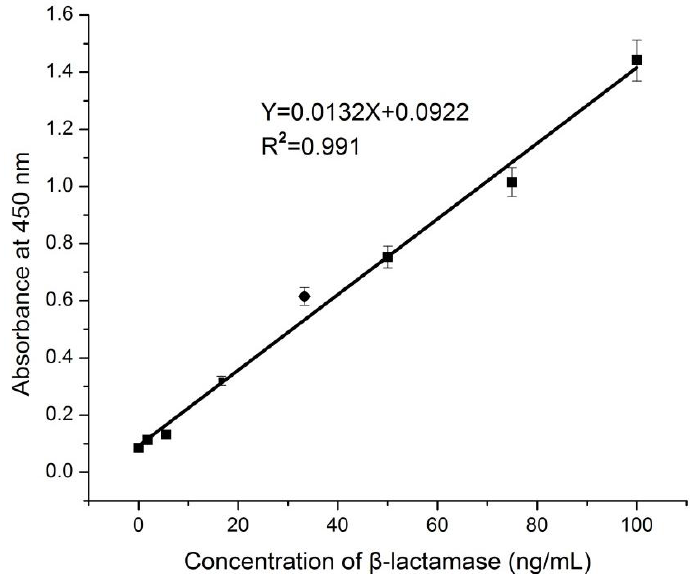
Points were means of triplicate